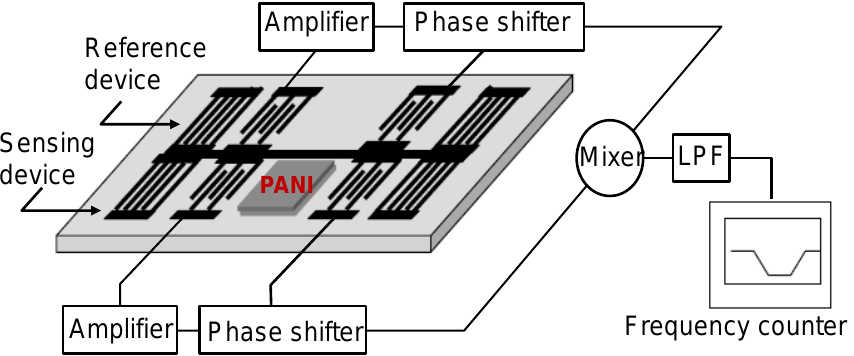
Figure 1. The schematic and principle of the SAW-based humidity